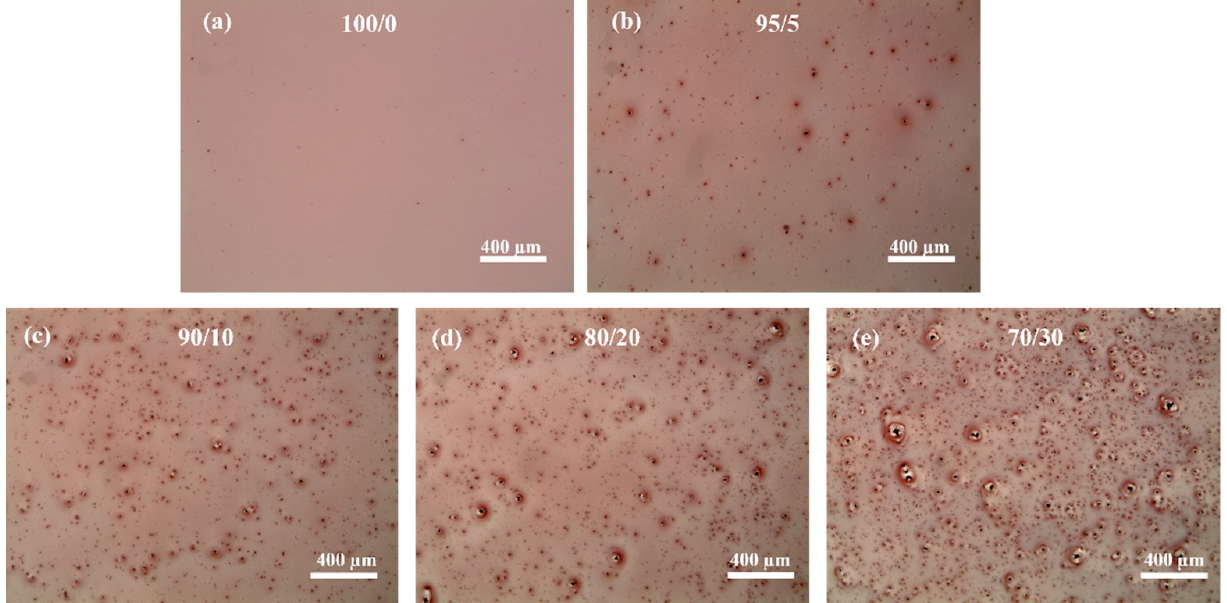
Figure 2. OM images of films deposited using photoirradiated solutions of ( a ) bare P3HT (100/0), ( b ) P3HT/g-C ₃ N ₄ (95/5), ( c ) P3HT/g-C ₃ N ₄ (90/10), ( d ) P3HT/g-C ₃ N ₄ (80/20), and ( e ) P3HT/g-C ₃ N ₄ (70/30).